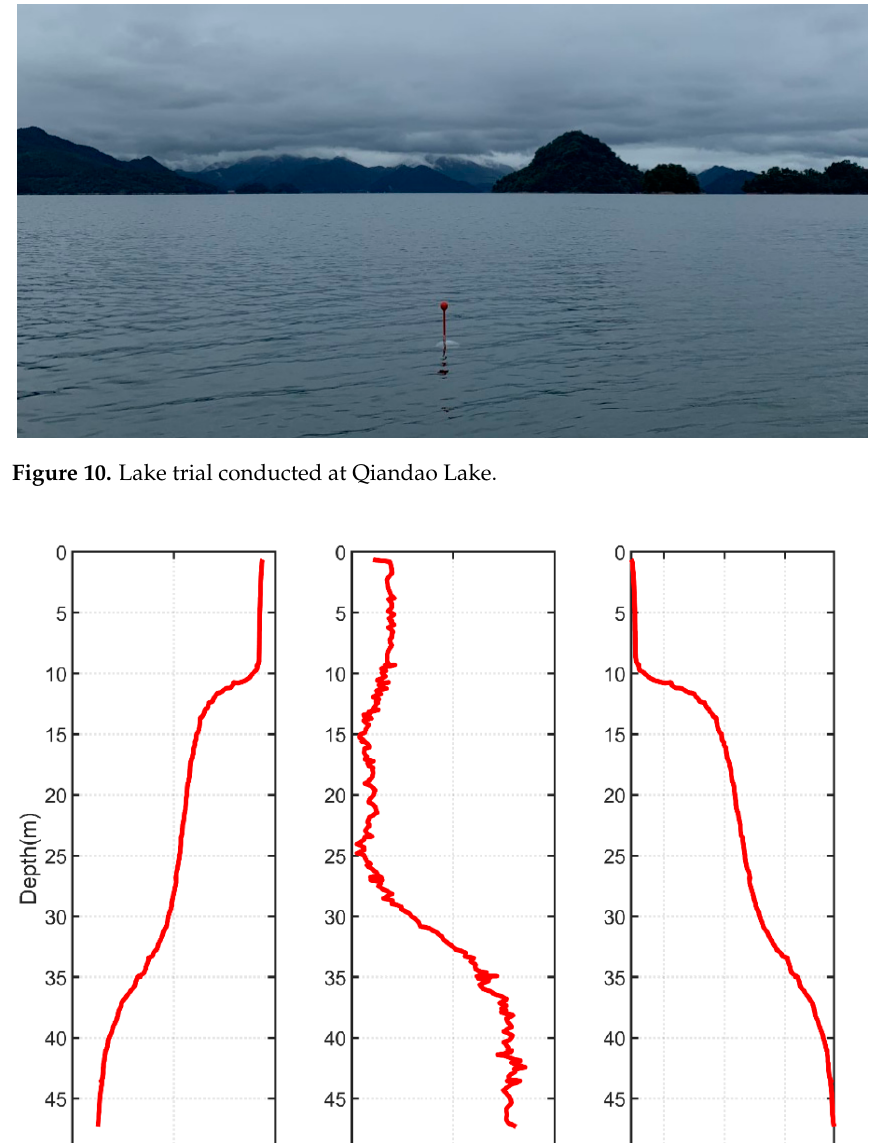
Table 2. Optimisation results based on adaptive genetic algorithm. Oil Draining Frequency First Depth (m)